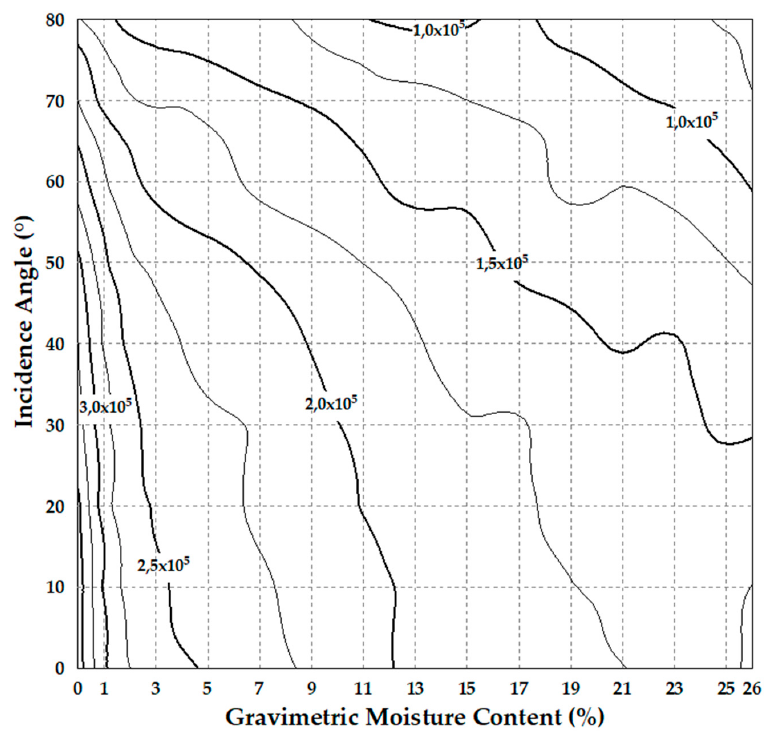
Figure 4. Contour lines of the Z&F/Leica HDS6100 original intensity versus the incidence angle (0–80°) and the gravimetric moisture contents (0–26%) when scanning sand samples from a fixed 5 m distance.